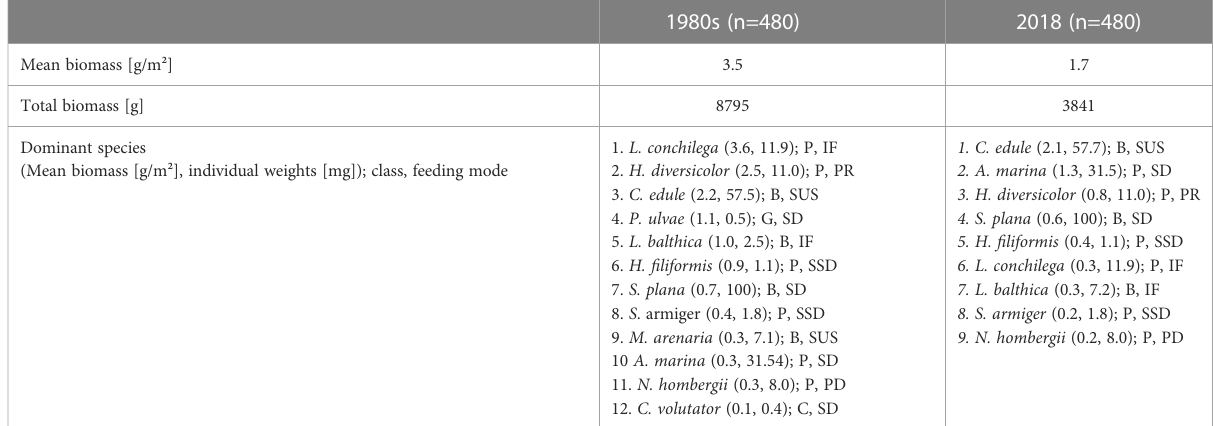
TABLE 3 Comparison of macrofauna biomass changes in the East-Frisian Wadden Sea (1980s versus 2018). B: bivalve, G: gastropod, C: crustacean, P: polychaete; PR: predator, SL: sandlicker, SD: surface deposit feeder, IF: interface feeder, SUS: suspension feeder, SSD: subsurface deposit